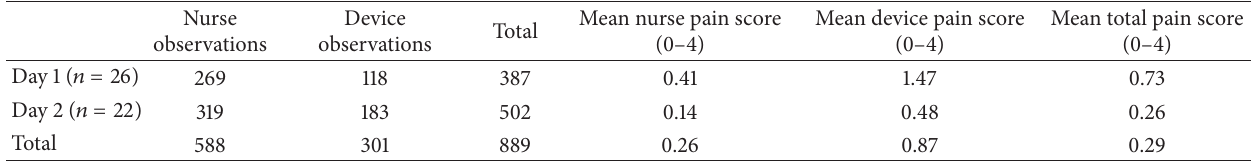
Table 4: The total number and average number per day of pain observations taken in the device group and mean pain scores recorded on day 1 and day 2.